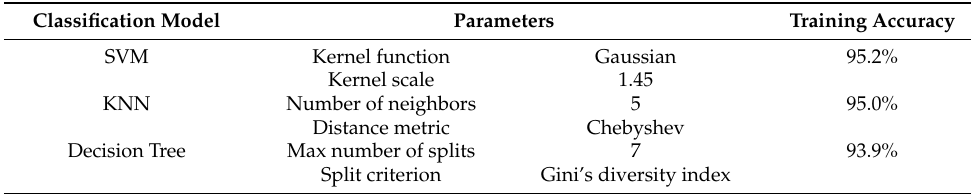
Table 2. Training accuracy of classification models.